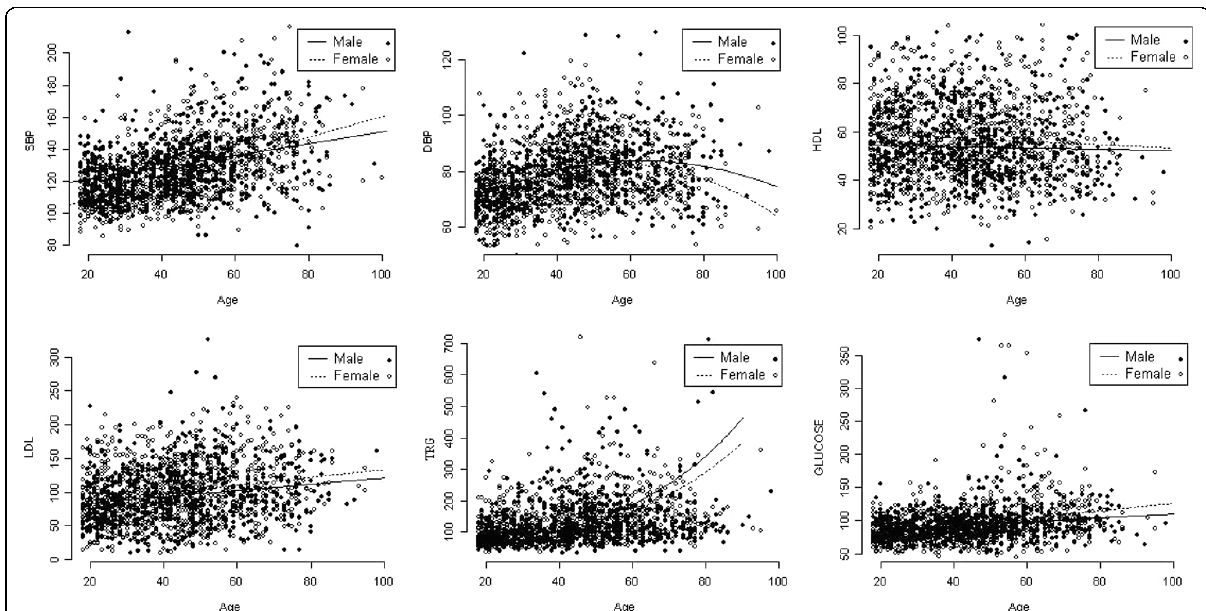
Figure 2 Values of six cardiovascular traits plotted for males (closed circles) and females (open circles) as a function of age in years . Regression curves fitted to the data show trends for males (solid lines) and females (dashed lines) with increasing age.